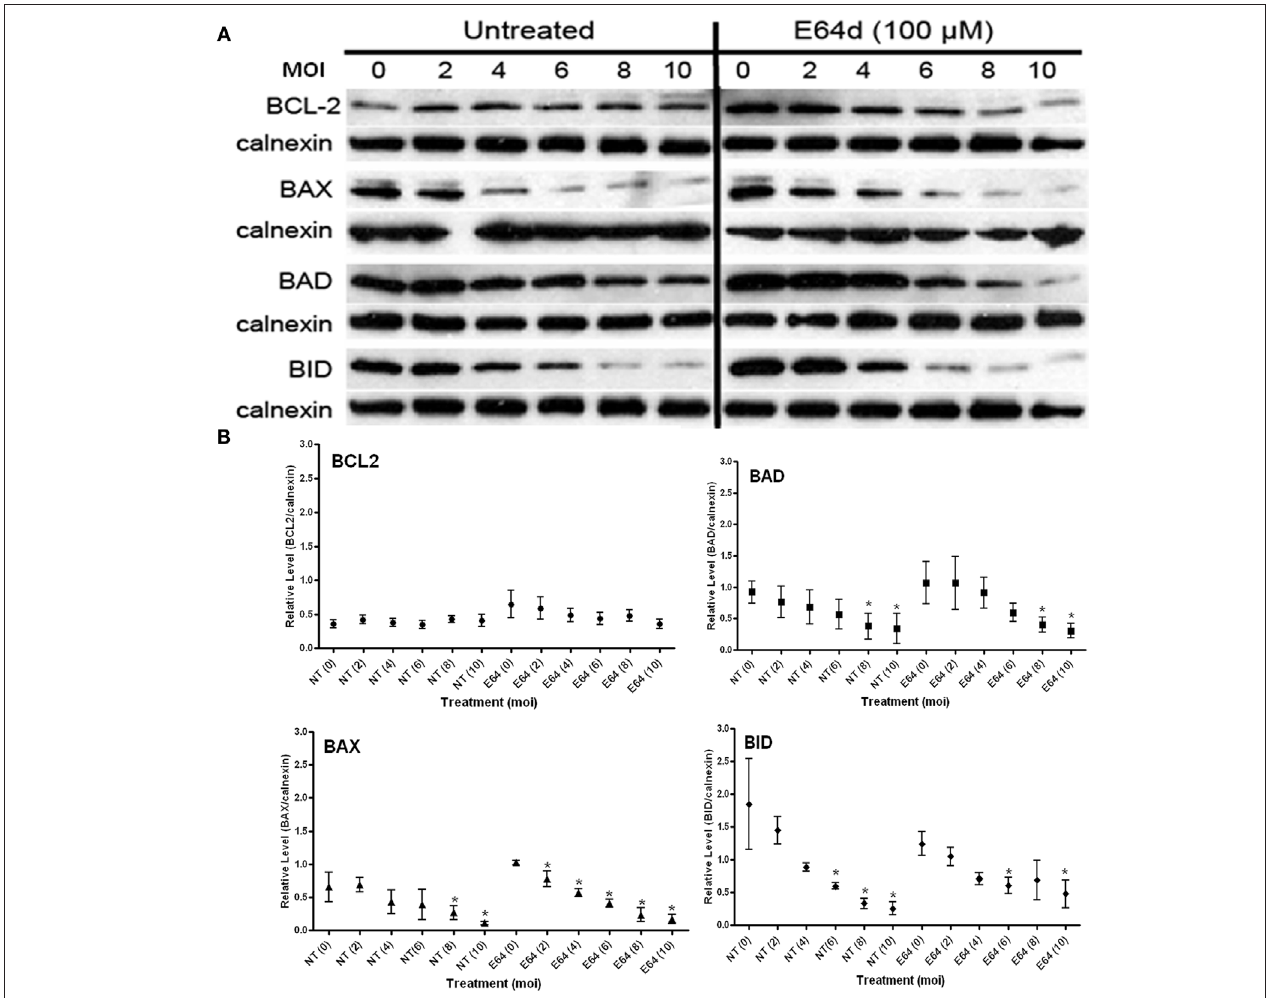
Figure 4 | effect of cysteine protease inhibition with e64d on the steady state levels of BCL2-family proteins in both uninfected (MOi = 0) and infected cells (MOi 2–10). (A) Representative immunoblots detecting the levels of the indicated BCL2-family members in response to increasing infection. Levels of calnexin are used as a loading control. (B) Quantification of the levels of specific BCL2-proteins relative to calnexin in response to increasing infecting dose. Profiles for no-treatment (NT, untreated) and treated (E64) samples are